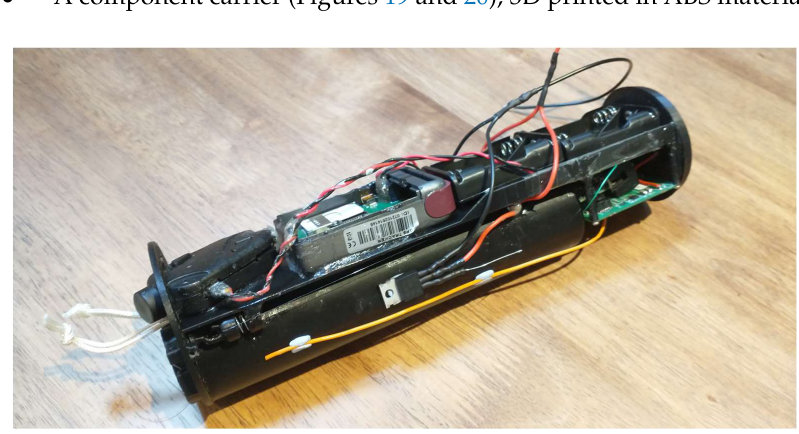
Figure 19. Component carrier with camera, GPS and battery packs visible at top.